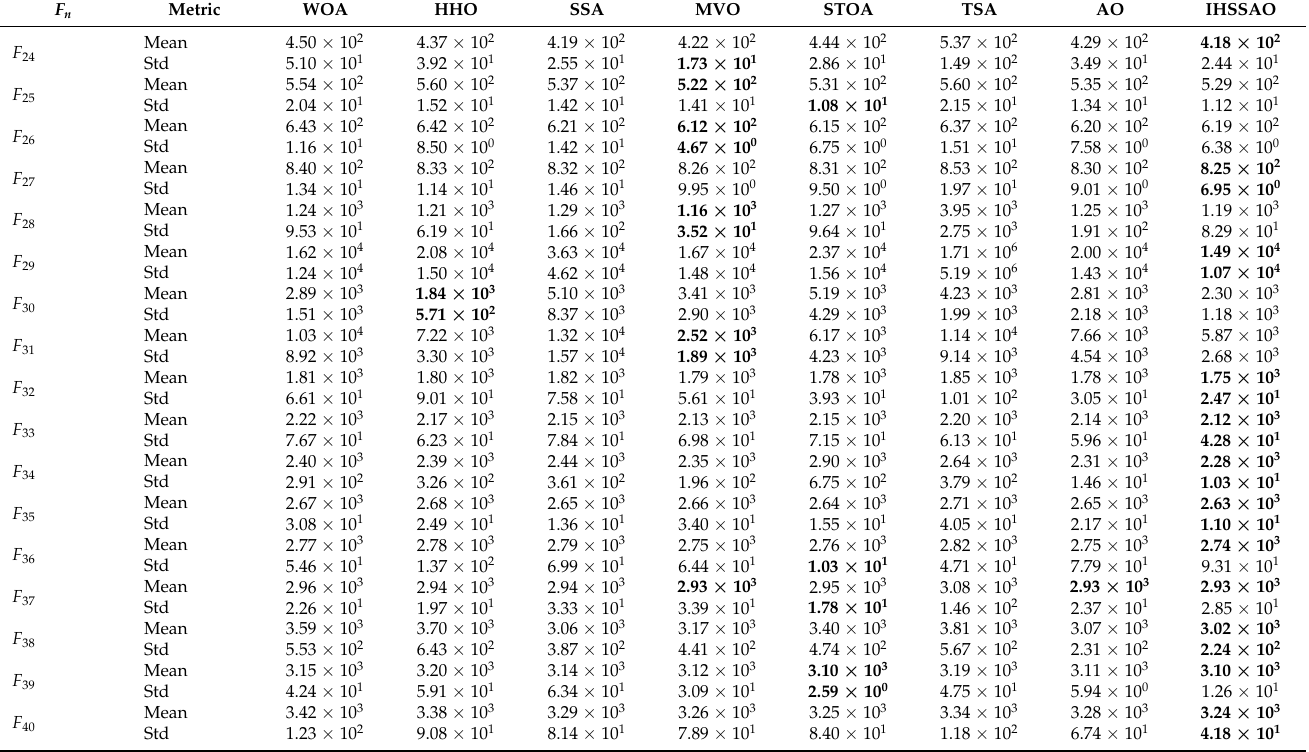
Table 9. Comparative results of HSSAO and other algorithms on 17 CEC2017